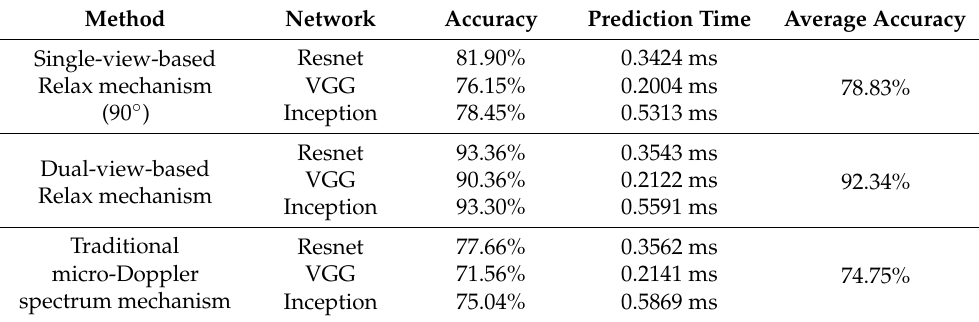
Table 4. Comparison of different ideas for elder fall